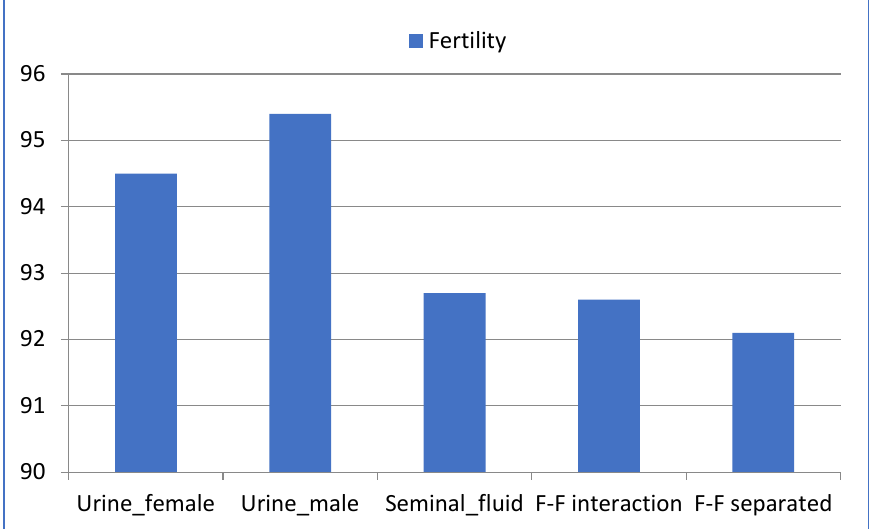
Figure 1. Fertility (kindling rate) in each of the different experimental groups.